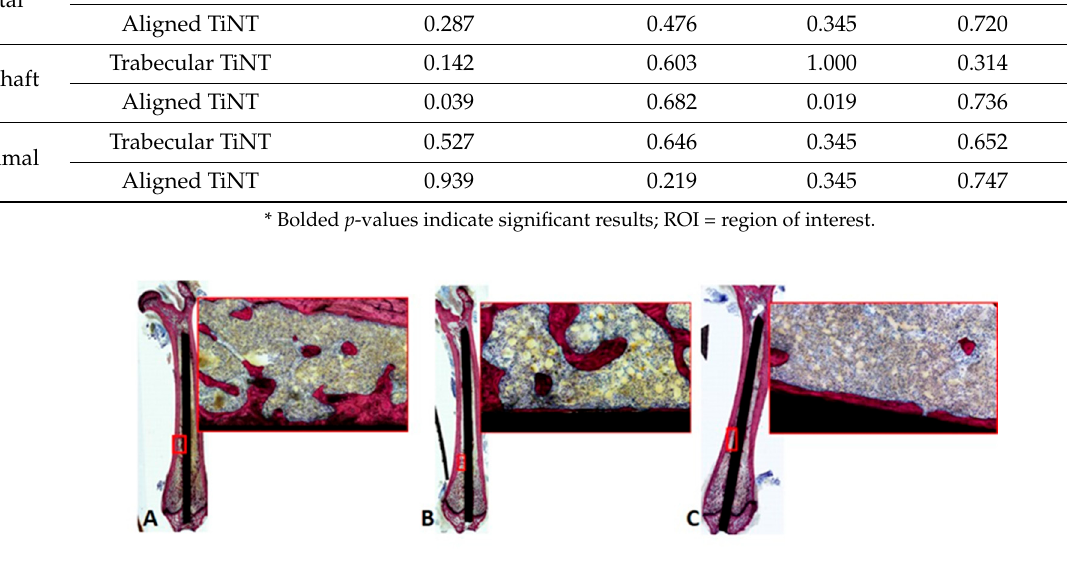
Figure 7. Longitudinal histologic sections and regions of interest of representative femora implanted with aligned TiNT ( A ), trabecular TiNT ( B ), and ( C ) control K-wires.